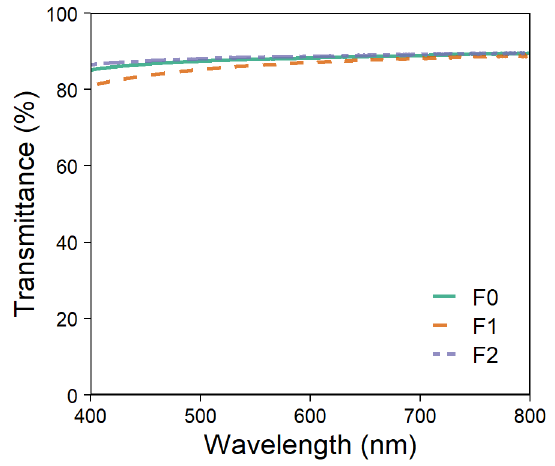
Figure 3. UV–Vis transmittance spectra of the coating film.